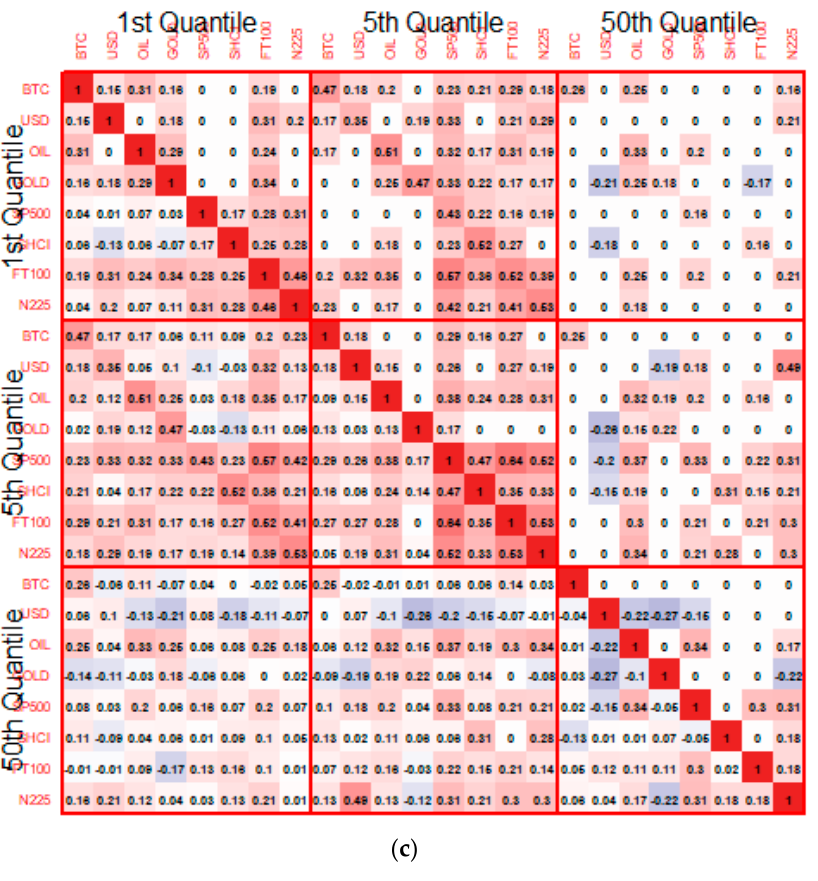
Figure 2. Quantile coherency (QC) matrices (quantile at 1%, 5% 50%). Note: Above the diagonal, non − significant values at 5% significance level are set to zero. Red and blue grids denote positive and negative values, respectively: ( a ) Short − term QC matrix; ( b ) Medium − term QC matrix; ( c ) Long − term QC matrix.